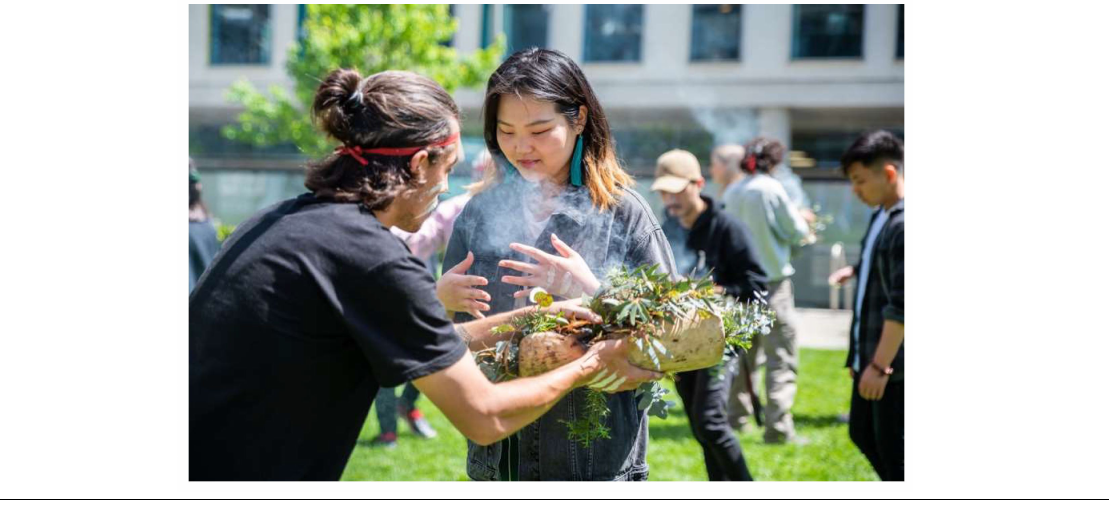
Figure 5. Smoking Ceremony, UTS Alumni Green in November 2018 (Source: photograph by Kwa